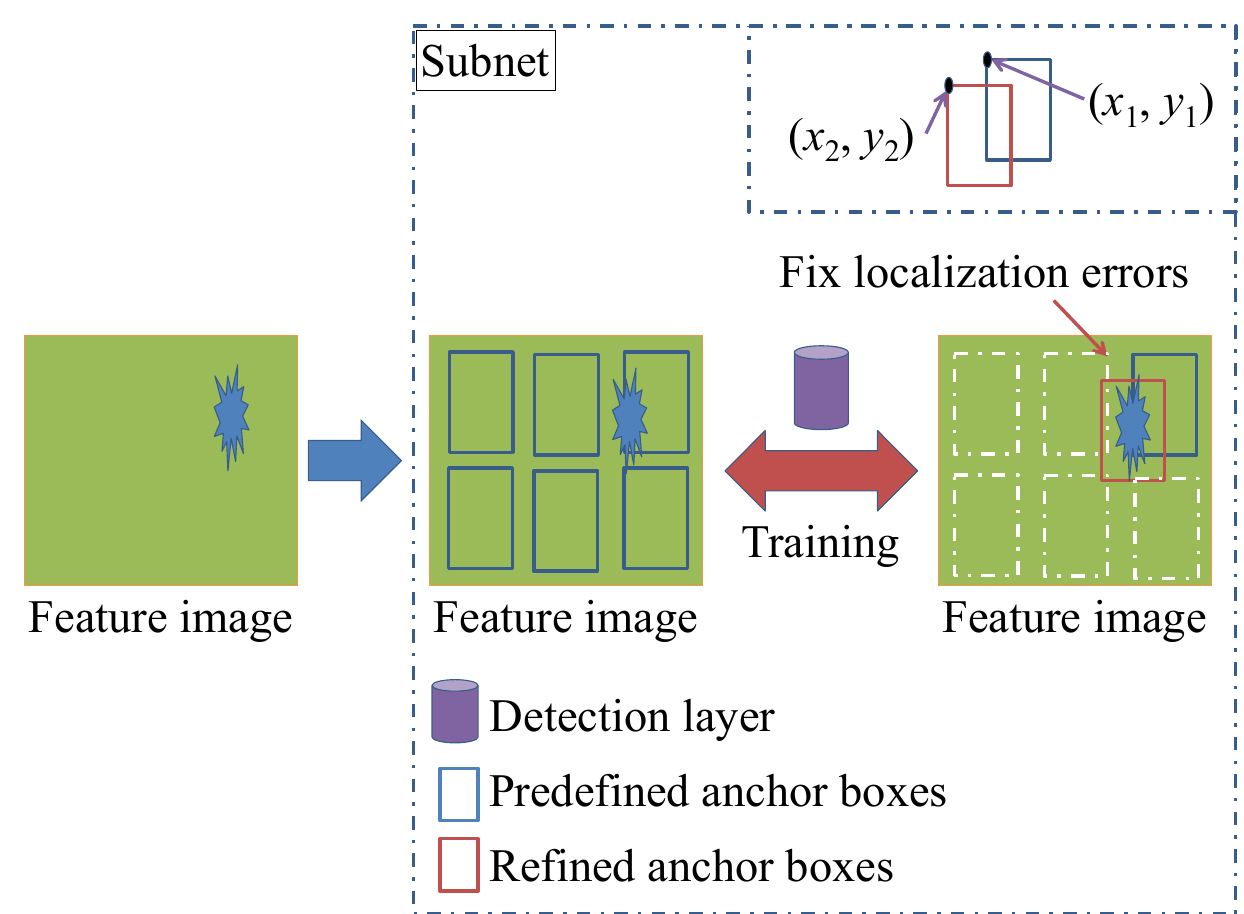
Figure 4. The detection process of the subnet.